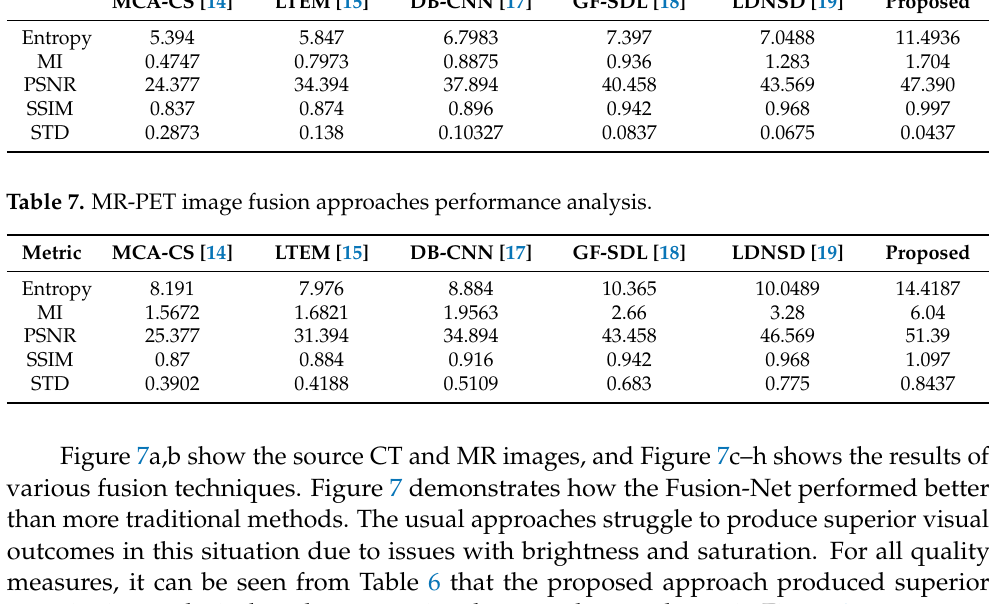
Figure 8. Percentage-based visual display of MR-CT image fusion methods (MCA-CS [14], LTEM [15], DB-CNN [17], GF-SDL [18], LDNSD [19]).